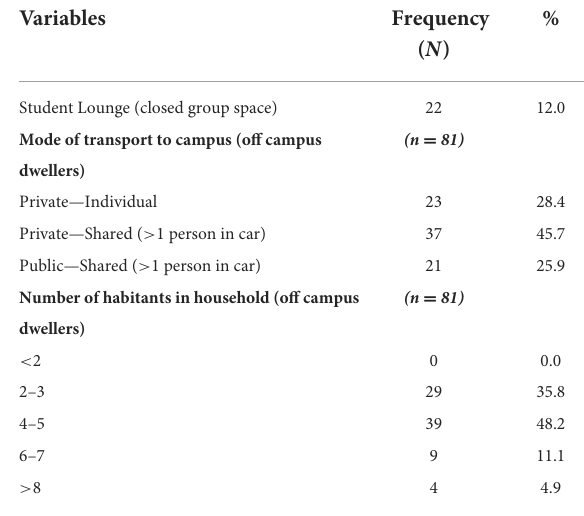
TABLE 1 Snapshot of study participants—demographics and exposure characteristics ( n =